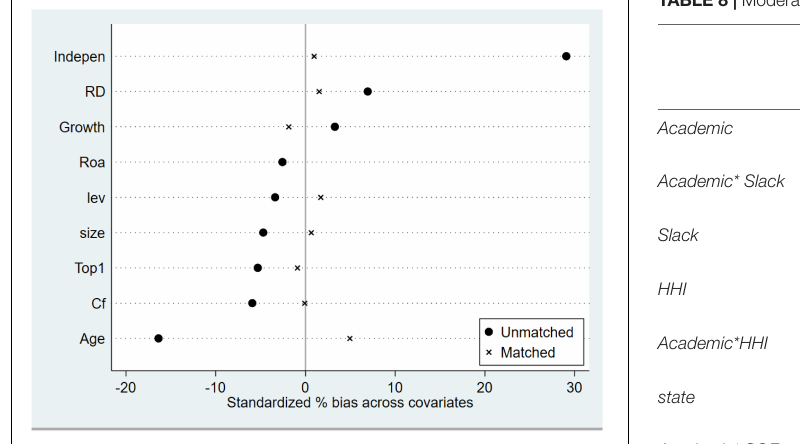
FIGURE 2 | Balanced test results. We subjected the control and treatment crude samples that had undergone psm to a balance test. The standard deviations of the control variables of the samples of the control and treatment groups were basically within 10%, indicating that the sample characteristics of the control and treatment groups were basically the same after the